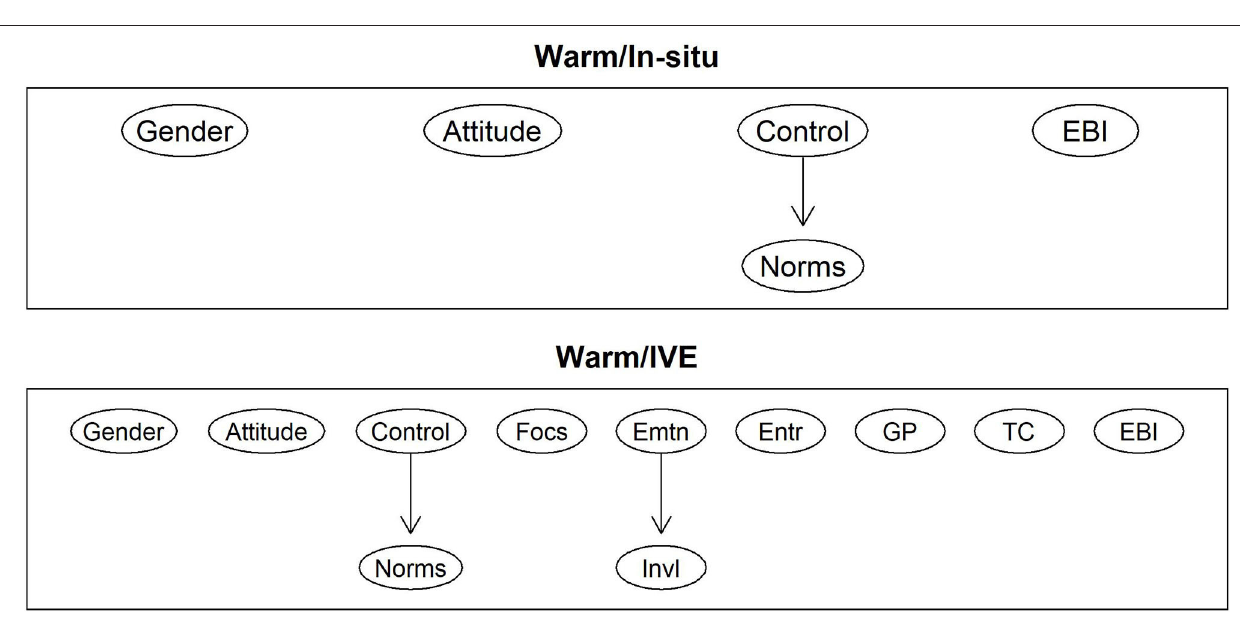
FIGURE 7 | SCM for EBI in warm/ in-situ (top) and Warm/IVE (bottom)